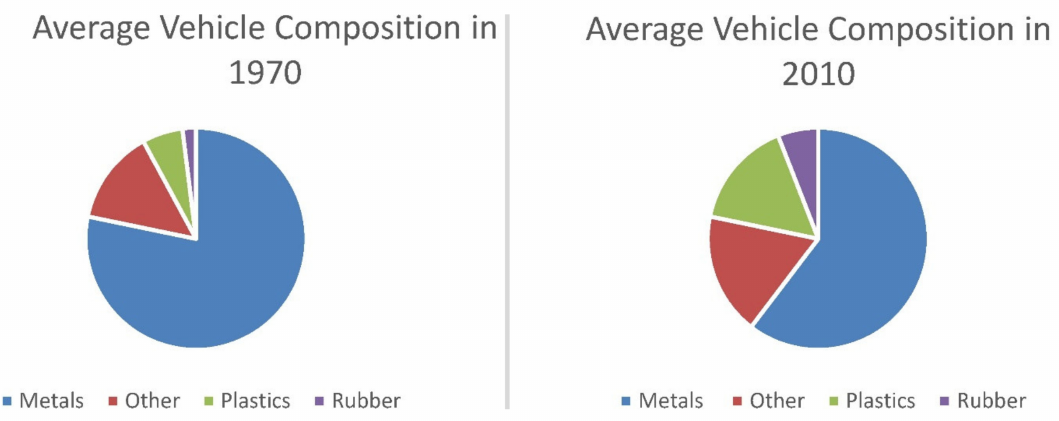
Figure 10. Change in vehicle composition from 1970 to 2010. Reprinted from